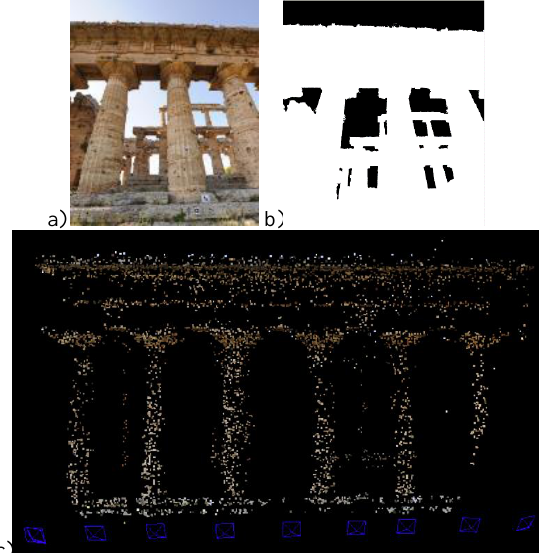
Figure 7: An image of the considered dataset (a), its corresponding automatically generated semantic mask in binary format (b) and the orientation results (c).